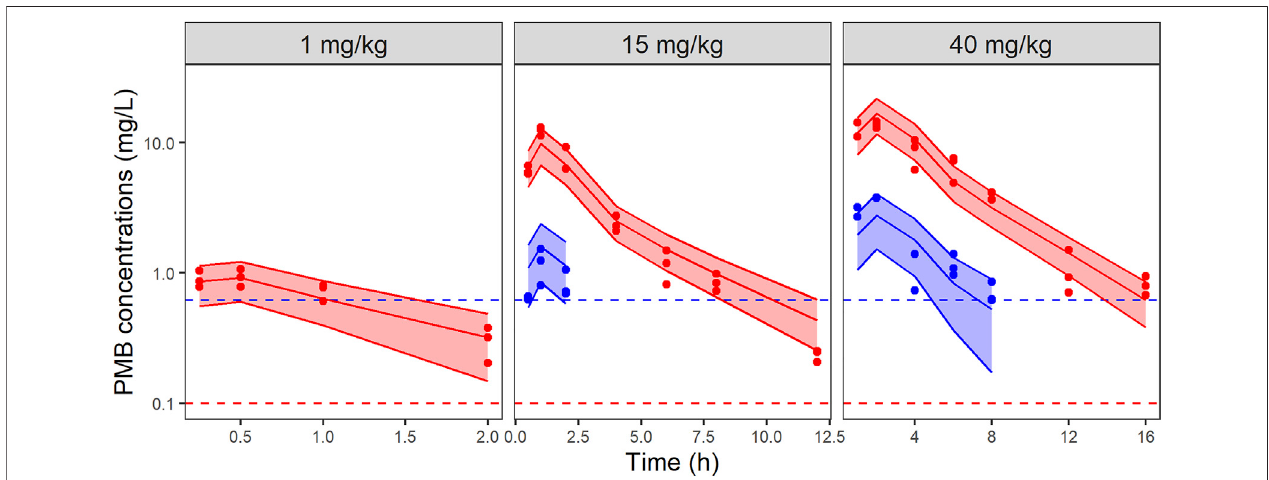
FIGURE 2 | VPCs of the fi nal PK model for total (red) and unbound (blue) PMB plasma concentrations, strati fi ed by dose. Circles represent observed data, solid linesrepresent the median of thesimulationsand the colored-shaded areas depict the 80%prediction intervals for1,000 simulatedpro fi les. Dashed lines correspondto the limits of quanti fi cation (0.1 mg/L and 0.62 mg/L for total (red) and unbound (blue) concentrations, respectively). Note the different axis scales.